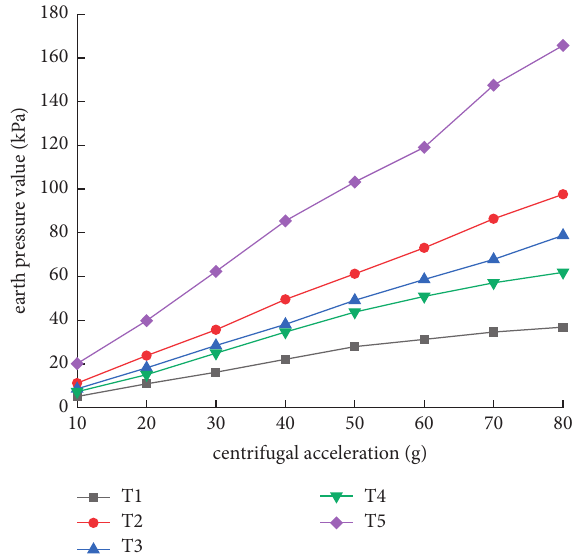
Figure 11: Variation curve of earth pressure in slope with